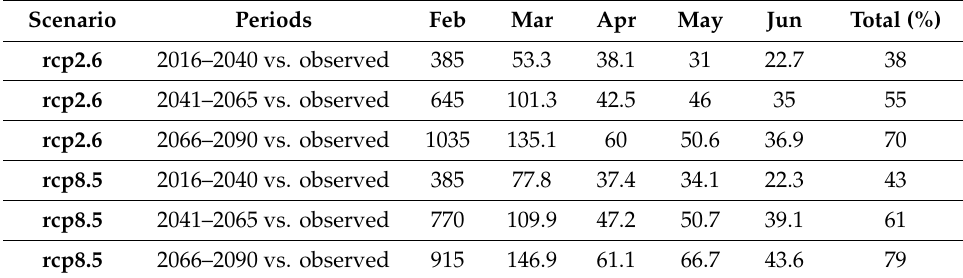
Figure 5. Comparison of the irrigation water requirement (IR) of barley under scenarios rcp2.6 and rcp8.5 for periods 2016–2040, 2041–2065, and 2066–2090 versus the baseline period. Table 7. Change values of the irrigation water requirement (IR) of barley in the periods 2016–2040, 2041–2065, and 2066–2090 and under the scenarios rcp2.6 and rcp8.5 with the baseline period.